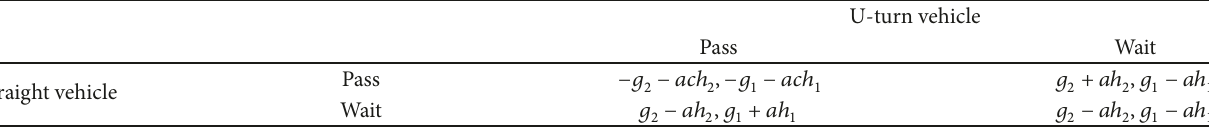
Table 1: Game payoff matrix.